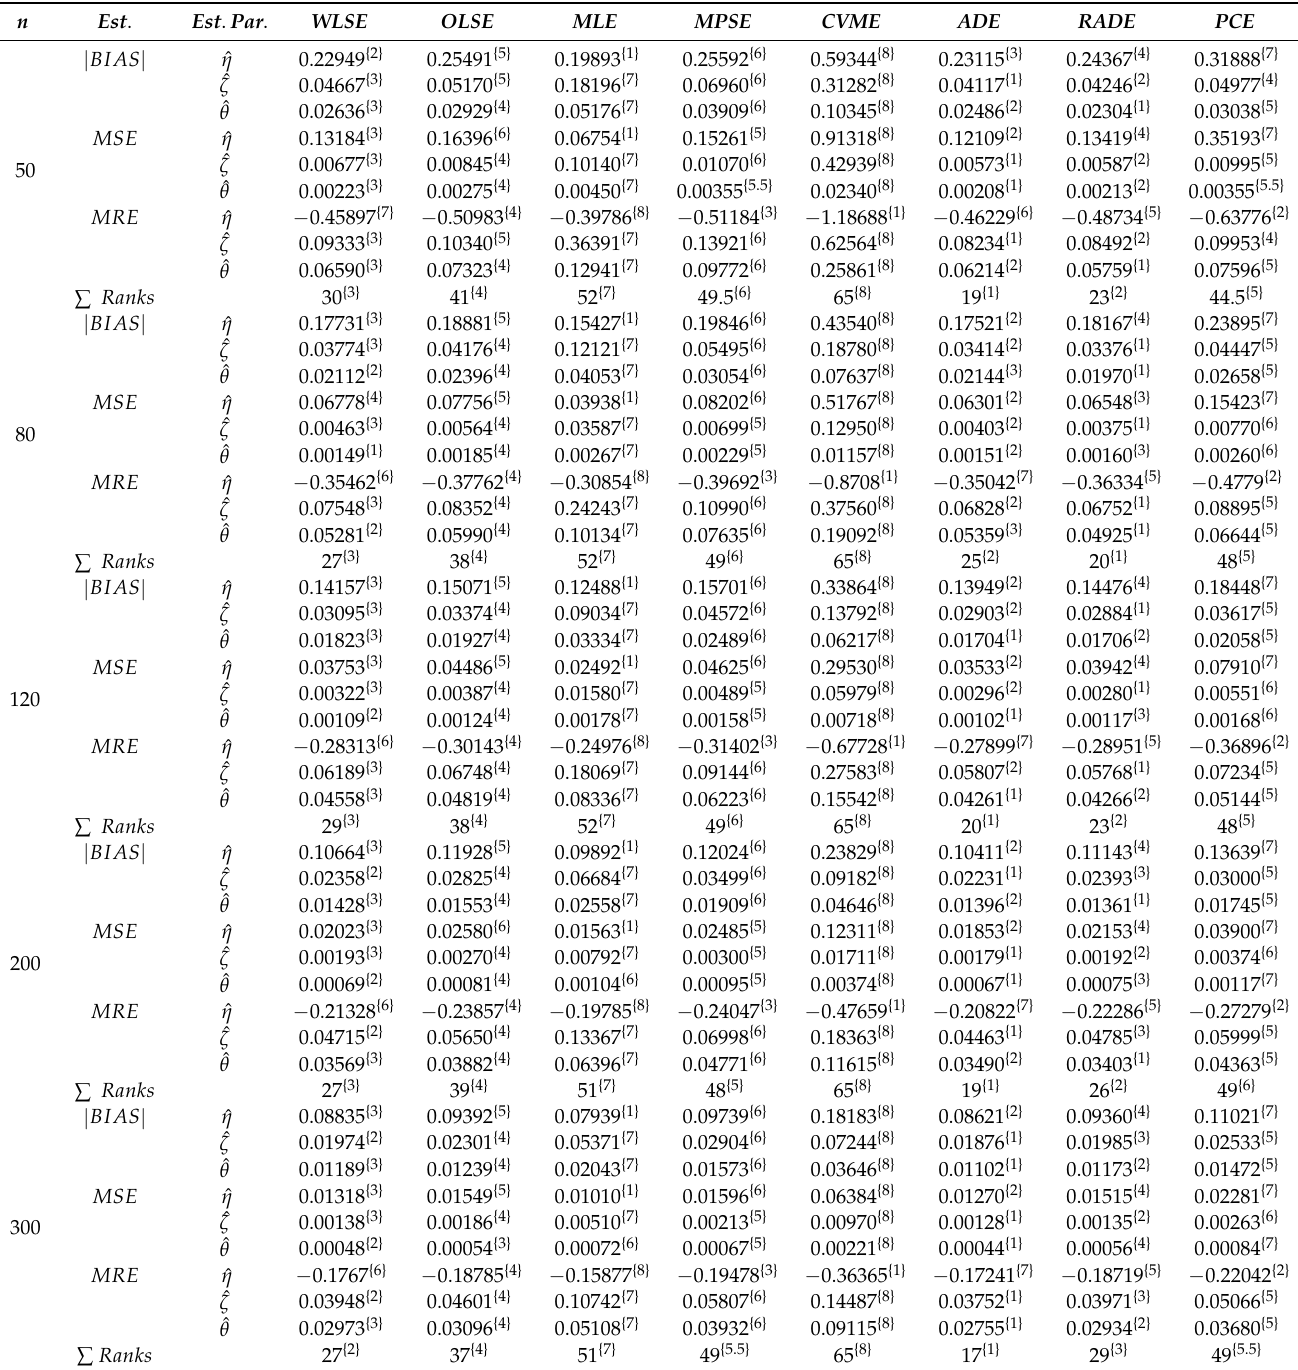
Table 3. Simulated results of the E-NPF distribution for Θ = ( η = − 0.50, ζ = 0.05, θ = 0.40 ) T